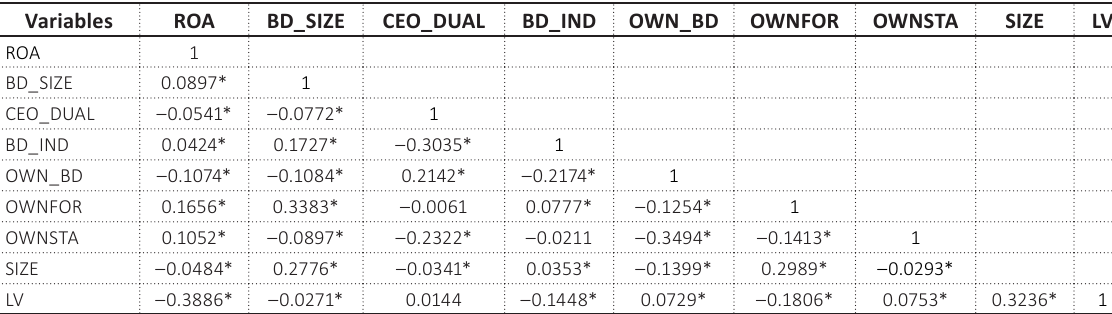
Table 3. Correlation matrix